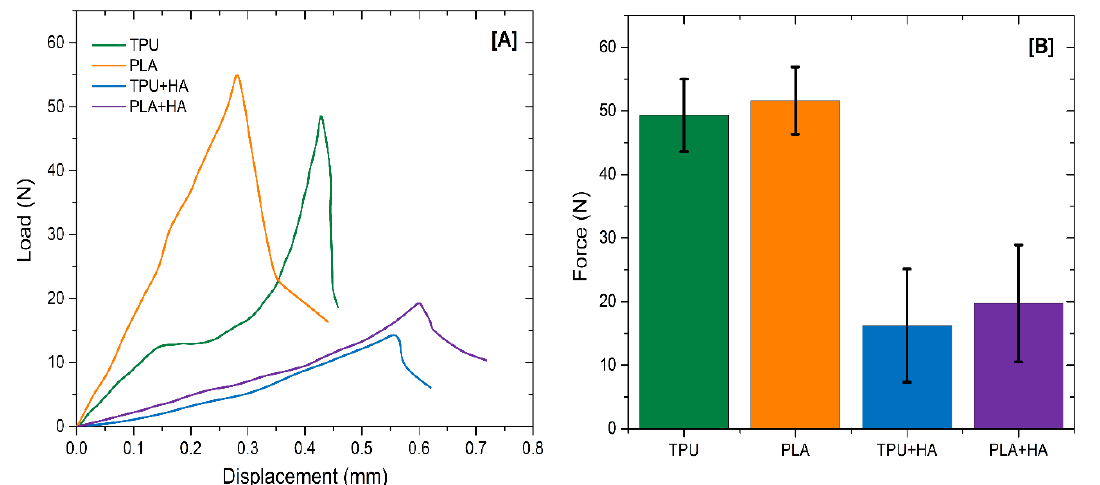
Figure 10. ( A ) Displacement force curves of TPU, PLA, the TPU-based materials obtained at 215 ◦ C, 60’ of exposure, and 2.5 × 10 − 4 MPa pressing force with HA particles embedded, and PLA-based materials obtained at 205 ◦ C, an exposure time of 60’, and a maximum pressing force of 0.5 × 10 − 4 MPa. (B) The maximum displacement forces for the same samples.